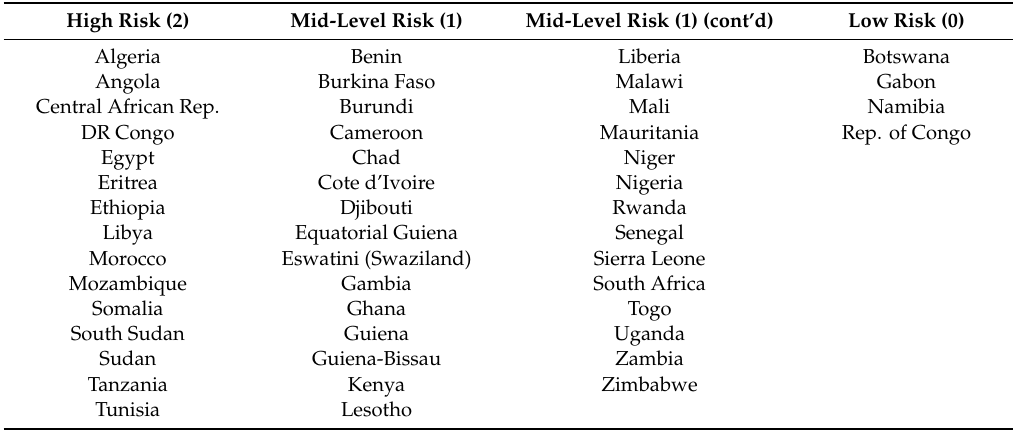
Table A1. Climate Risk (countries categorized according to their historical physical exposure to climate-related hazards and population density in a ff ected areas)